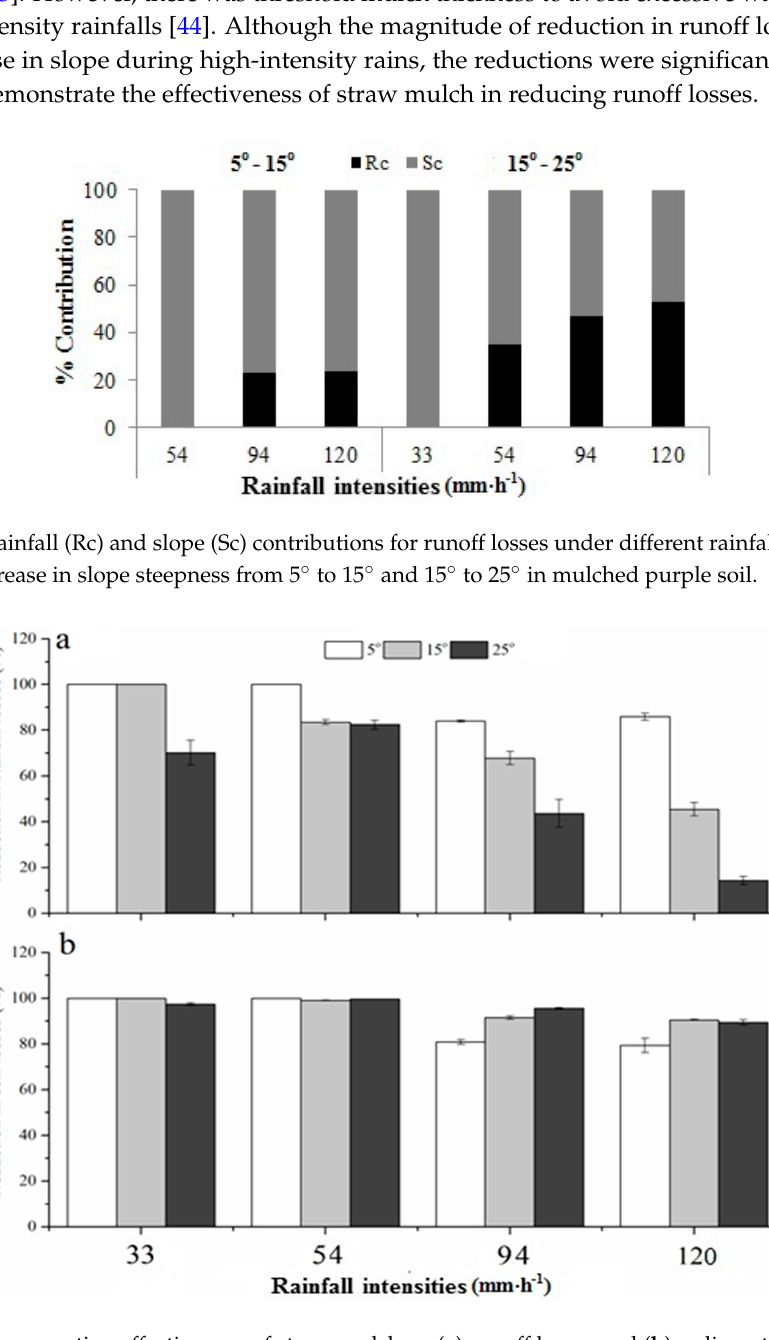
Figure 4. Conservation effectiveness of straw mulch on ( a ) runoff losses and ( b ) sediment losses from purple soil. Mean values ( n = 3) are given with standard deviation (S.D).